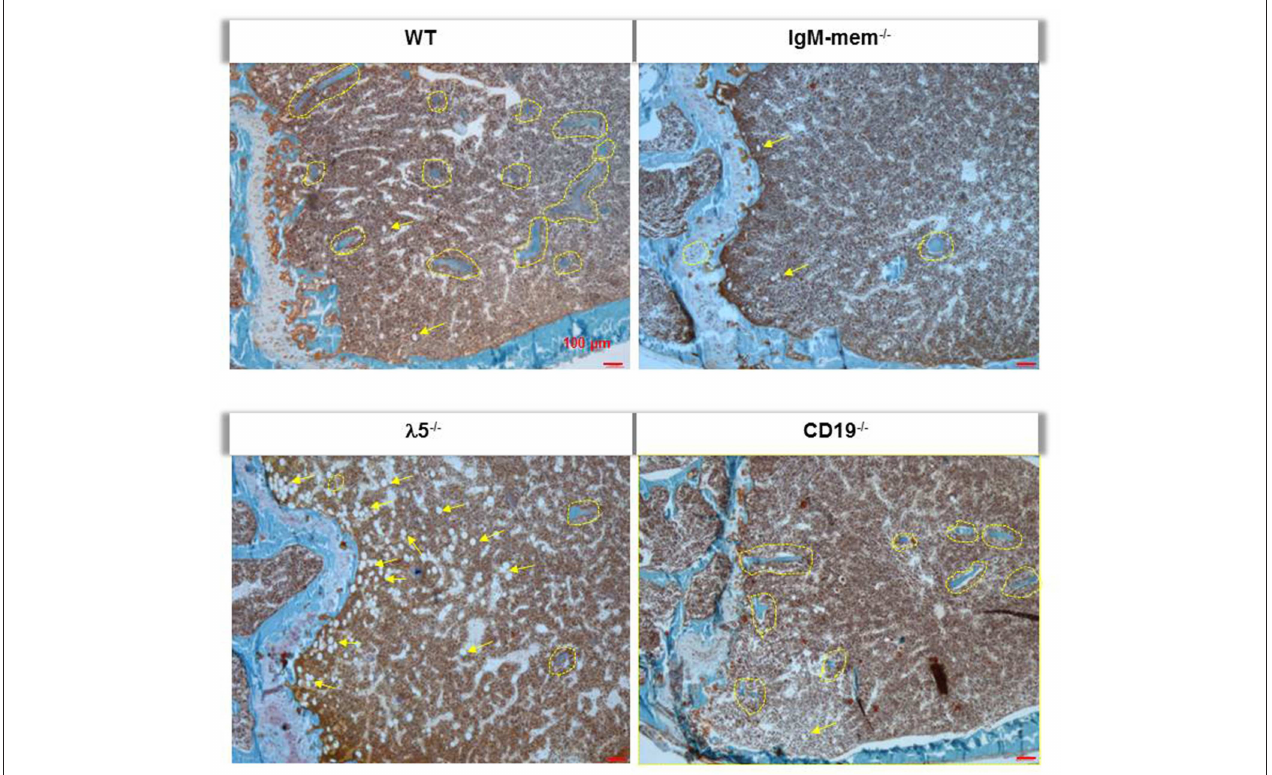
FIGURE 3 | Deficiency of λ 5 is associated with decreased adult bone mass. Undecalcified femurs from 6-month-old female WT and the indicated mutant mice were embedded in plastic, sectioned laterally, and stained with Goldner’s trichrome. Representative images of the central region surrounding the growth plate are shown at 10x magnification. Individual mineralized trabecular bone beneath the growth plate are identified with yellow dotted lines. Marrow adipocytes in all histologic sections are indicated by yellow arrows.